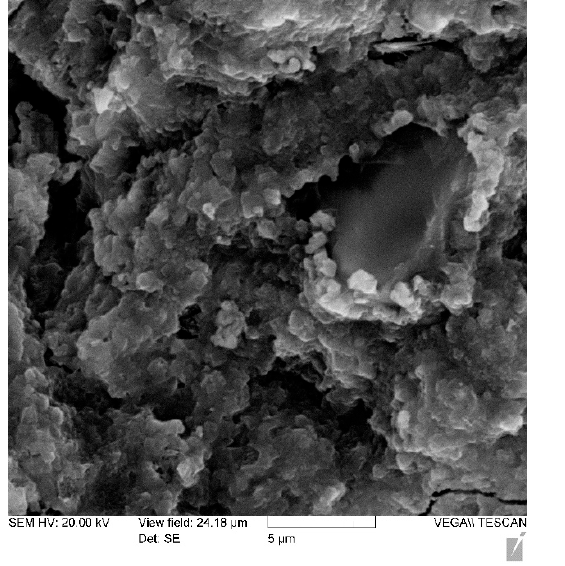
Figure 10. Photo of the microstructure of a cement stone with an MS-85 additive in an amount of 10% and an additive of